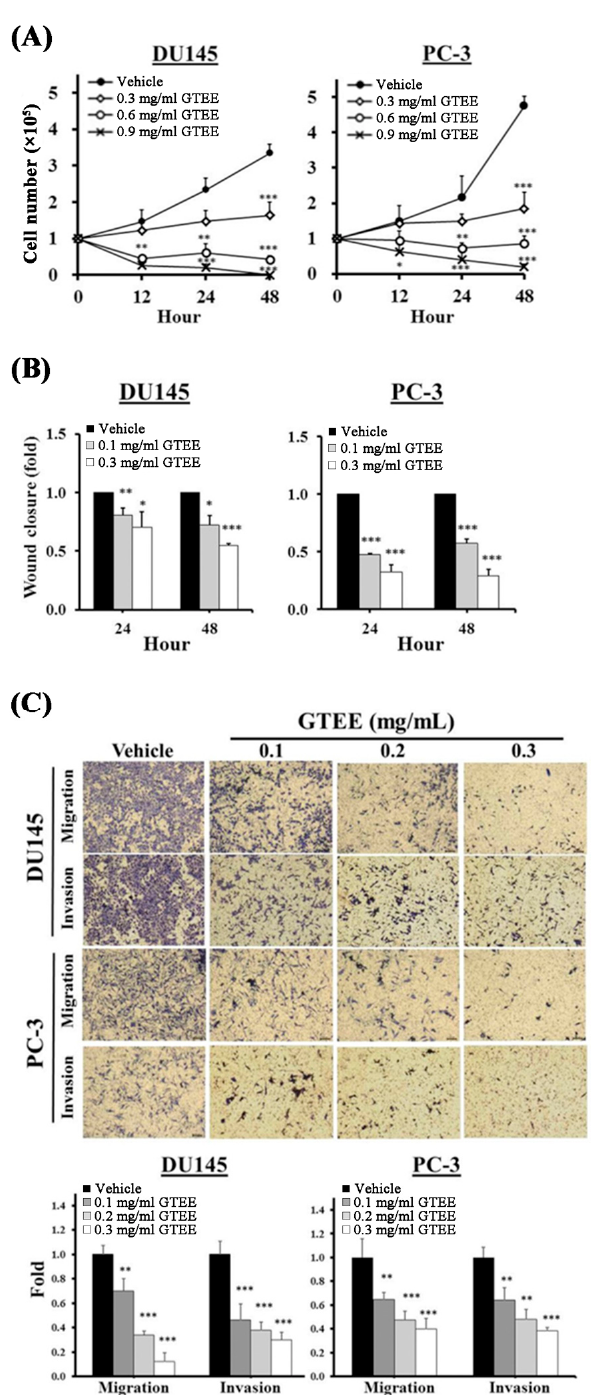
Figure 1. Ganoderma tsugae ethanol extract (GTEE) inhibits cell growth and metastatic capability of metastatic prostate cancer (mPCa) cells. ( A ) DU145 and PC-3 cells were treated with vehicle or GTEE (0.3, 0.6 or 0.9 mg / mL) for 0, 12, 24 and 48 h. Cell growth curves were determined by cell number counting. ( B ) A wound-healing assay was used to determine the e ff ect of GTEE on the cell migratory ability. DU145 and PC-3 cells were treated with vehicle or GTEE (0.1 or 0.3 mg / mL). Wound closure was determined by migratory distance at 24 and 48 h. ( C ) The migration and invasion assays of DU145 and PC-3 cells treated with vehicle or GTEE (0.1, 0.2 or 0.3 mg / mL) for 24 h were performed. Images of DU145 and PC-3 cells in migration and invasion transwell assays. Data are shown as the mean ± SD of three independent experiments. * p < 0.05, ** p < 0.01, *** p <